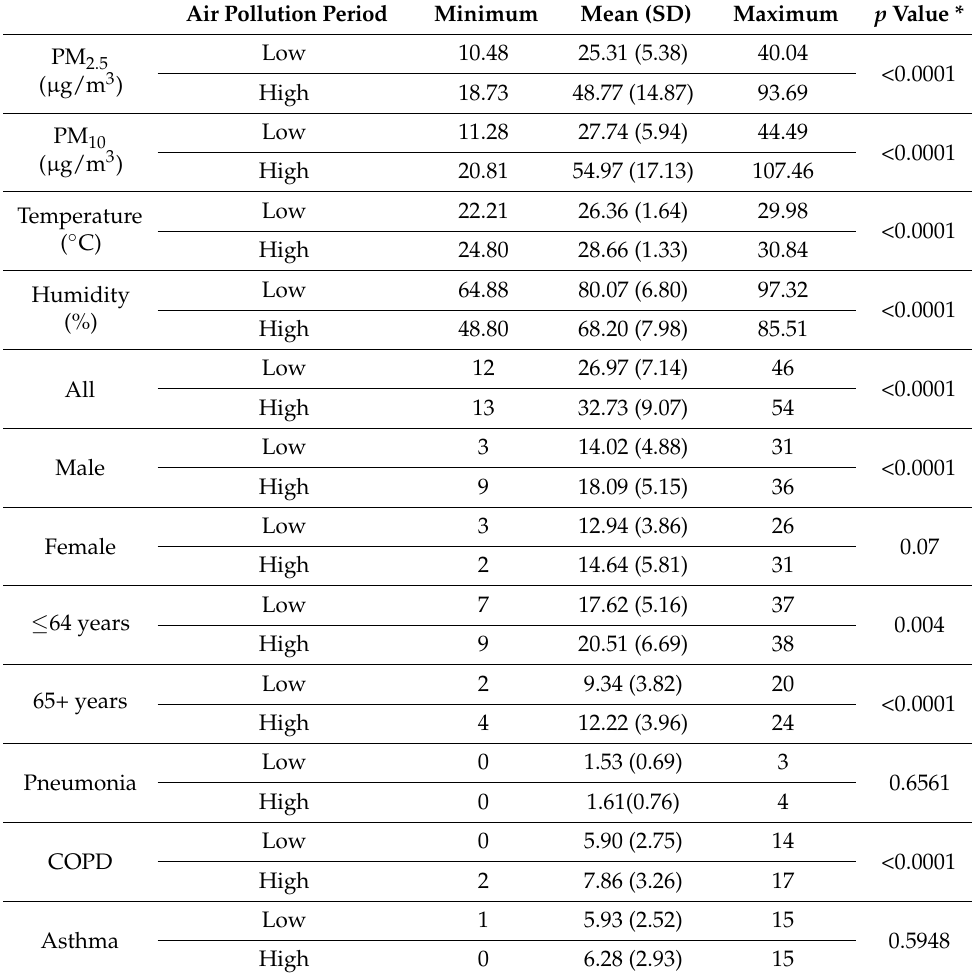
Table 3. Descriptive statistics of daily air pollution levels and daily respiratory disease hospital admissions in two air pollution periods (in selected months).